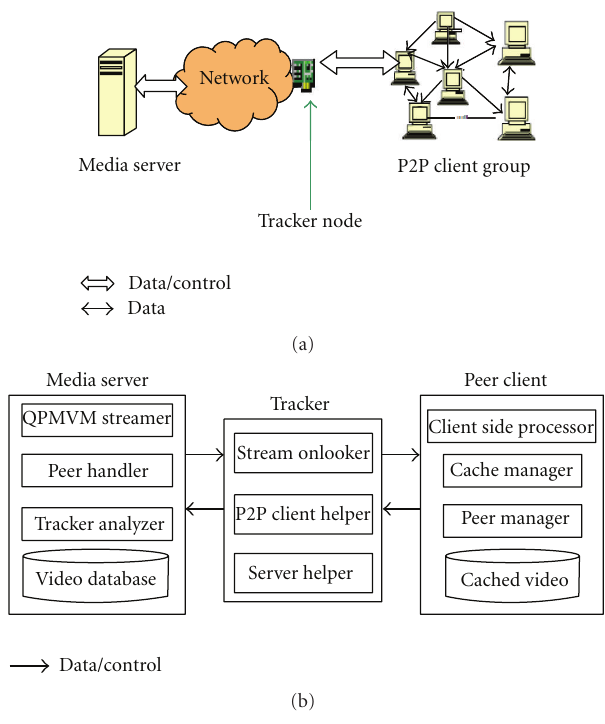
Figure 1: (a) System architecture; (b) High level